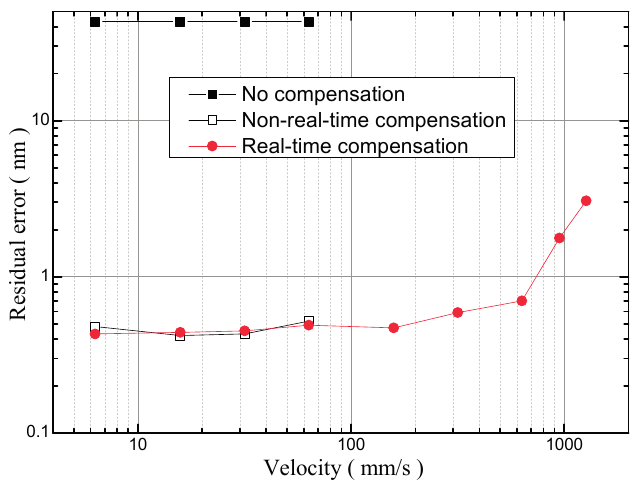
Figure 14. Cyclic error vs. velocity of the target mirror, the residual error was measured after a linear fit. Note that when the simulation velocity of the target mirror was greater than 100 mm/s, no experimental results were obtained regarding the cyclic error without compensation or the cyclic error with non-real time compensation because the maximum sampling rate of DAQB was limited to 1.2